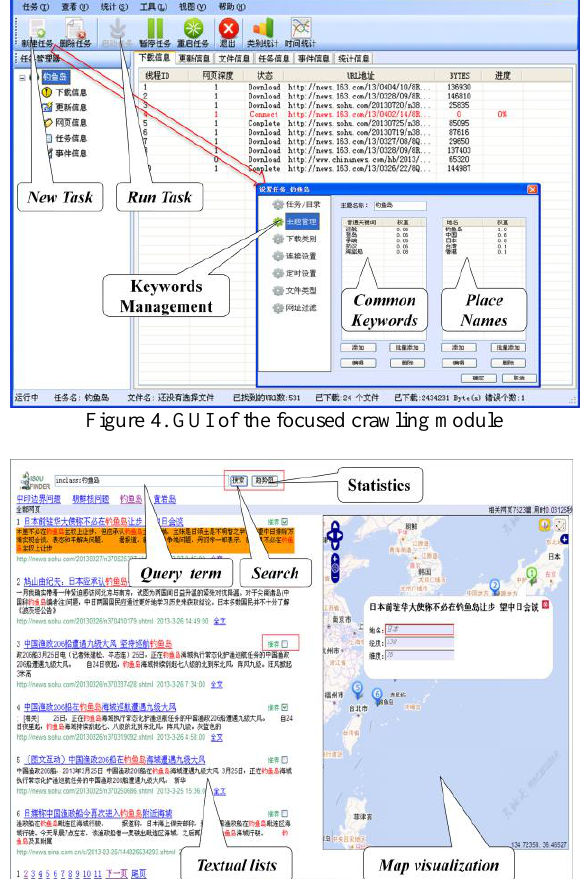
Figure 5. The main user query interface of the